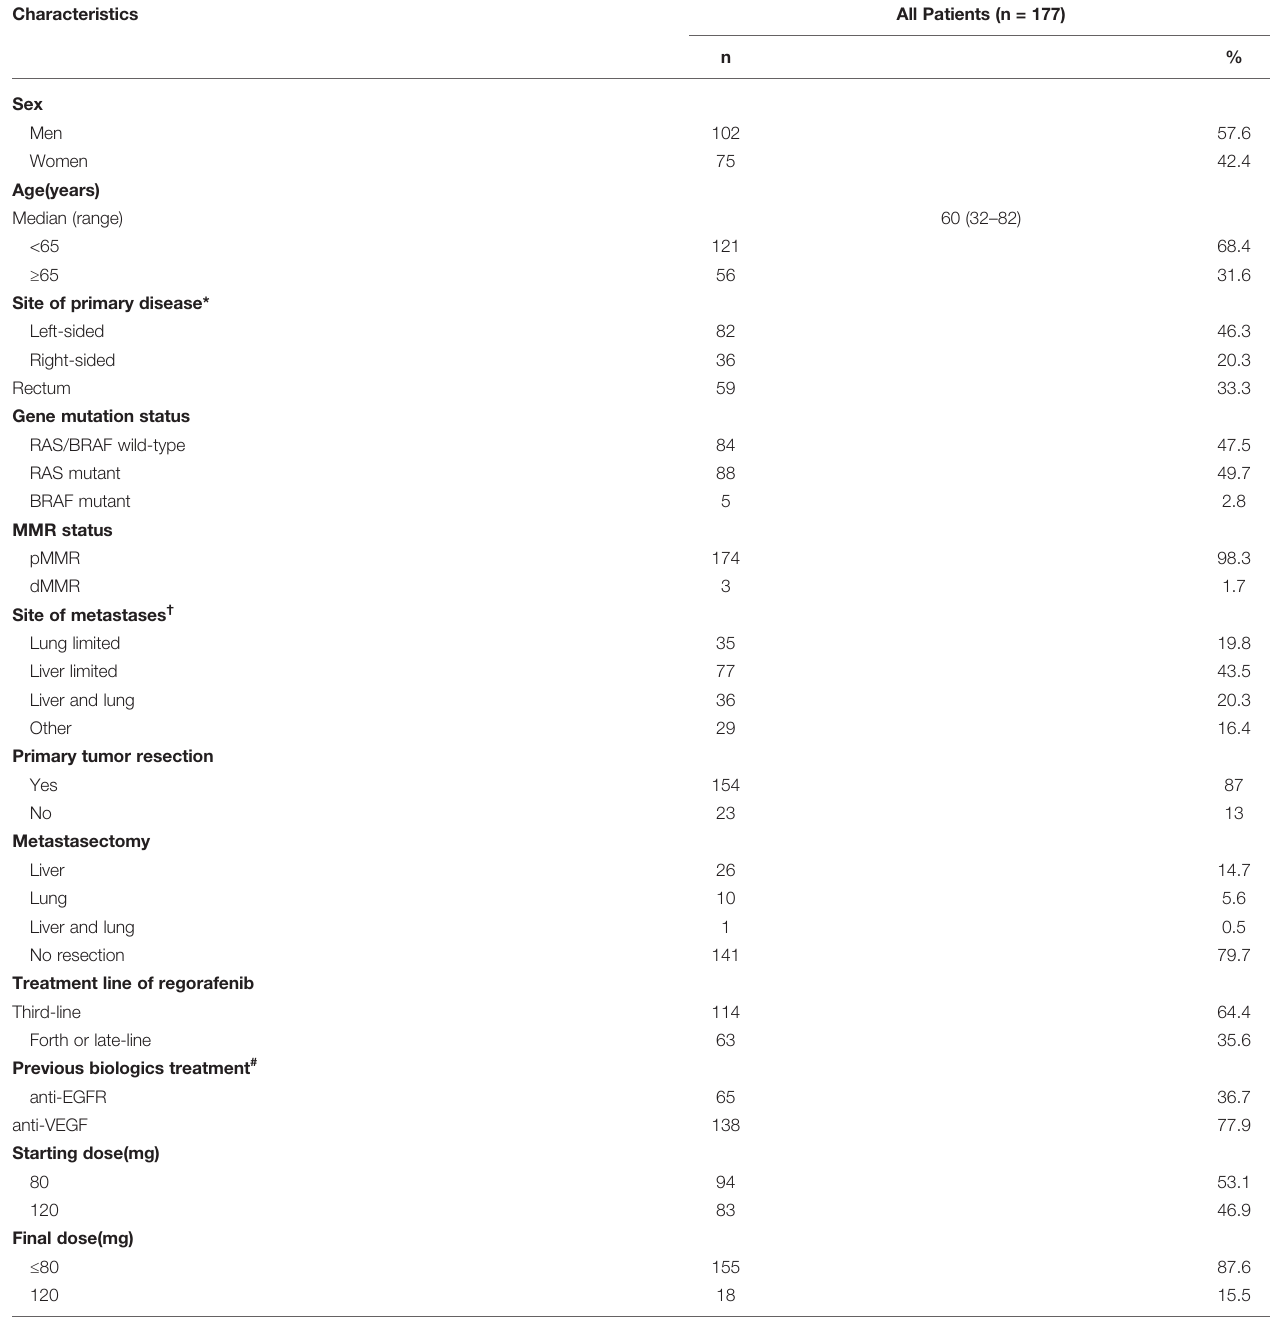
TABLE 1 | Baseline demographic and clinical characteristics of 177 mCRC